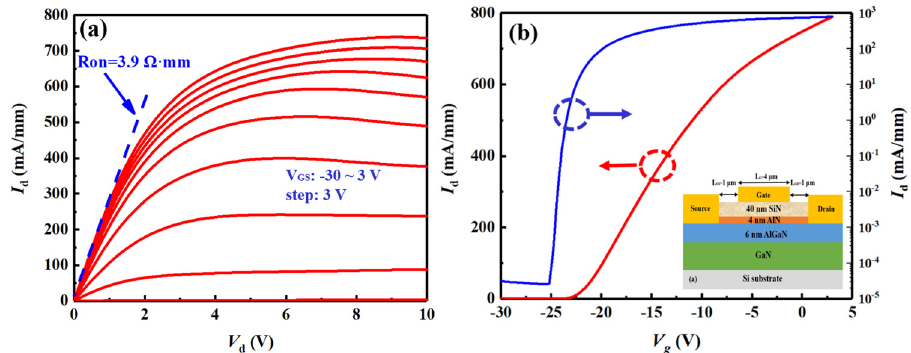
Figure 6. ( a ) Output characteristics and ( b ) transfer characteristics of the device based on UTB − AlGaN/GaN heterostructure with PEALD − AlN/PECVD − SiN x passivation.